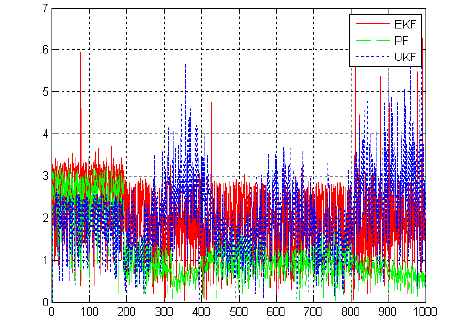
Figure6. Y direction positioning error comparison under three kinds of filter